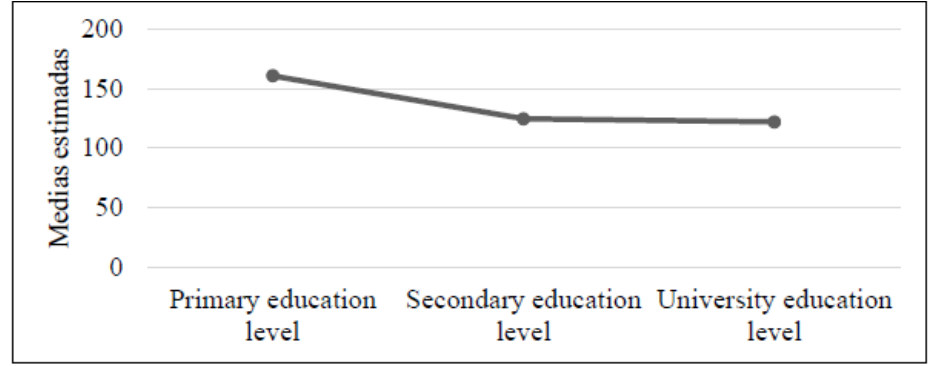
Figure 7. Estimated average use of vamos by educational level.